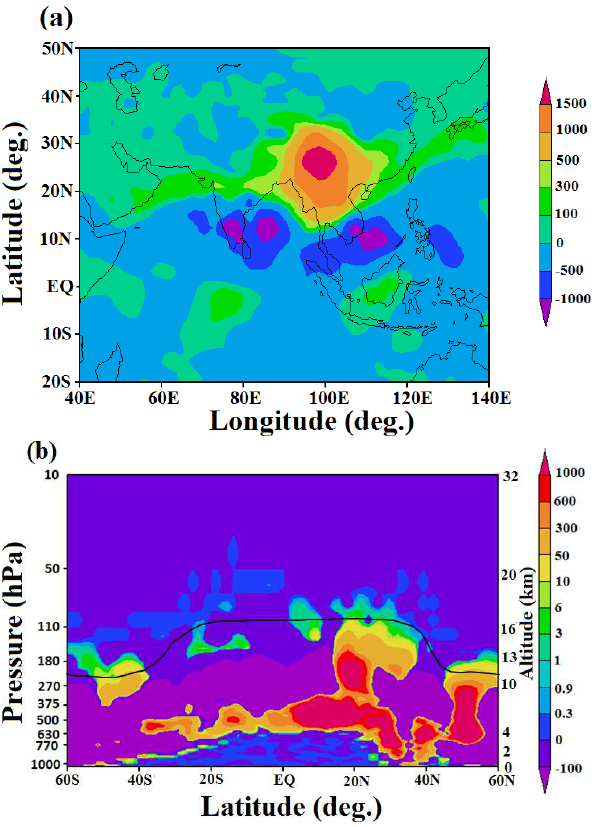
Fig. 9. Spatial structure of mean cloud ice (µgm − 3 ) anomalies as obtained from ECHAM5-HAMMOZ CTRL–NOAER runs during ASM. (a) Pressure level slice at 181hPa. (b) Latitude–pressure dis- tribution averaged over 60–120 ◦ E.